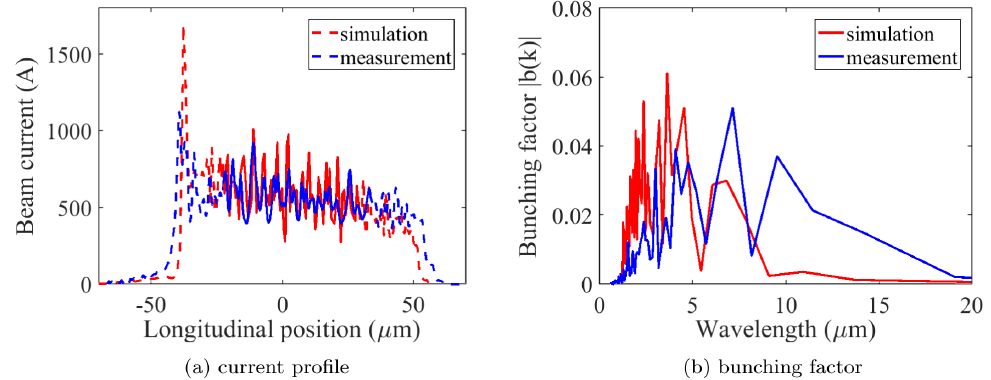
FIG. 10. The final current profile (left) and bunching factor (right) of the Fig. 9 longitudinal phase-space distribution with the laser heater